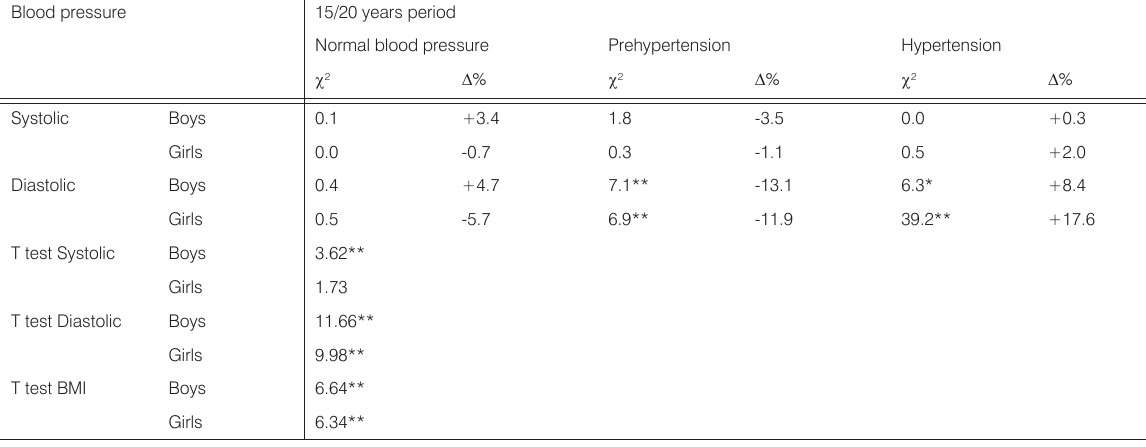
Table 3 Evaluation of blood pressure and BMI in children age between 15 and 20 years Blood